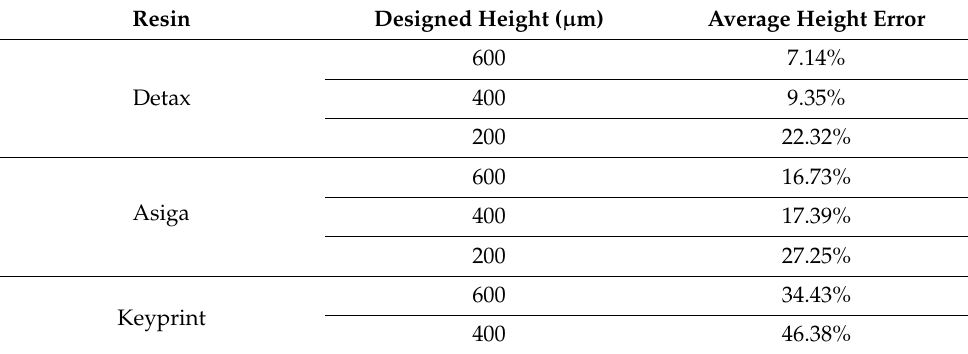
Table 2. Height error for every resin type and every different height design.